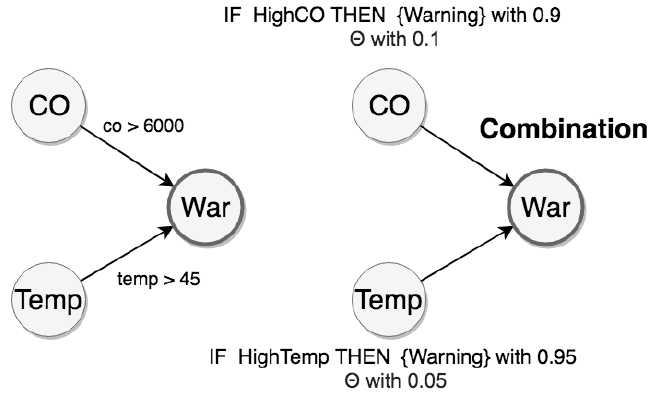
Figure 8. Representations of the warning